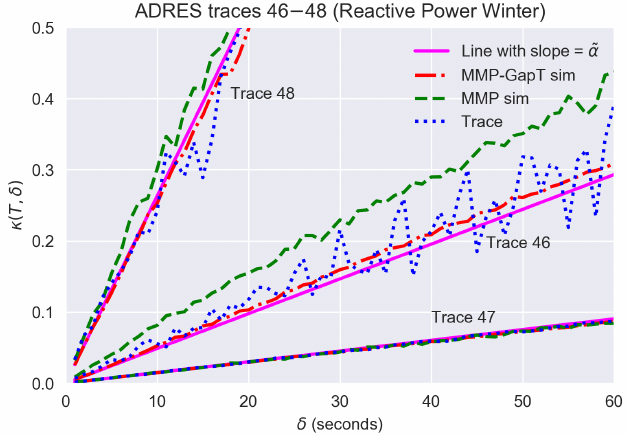
Figure 5. Comparison of Normalized Time Alignment Error κ ( T , δ )